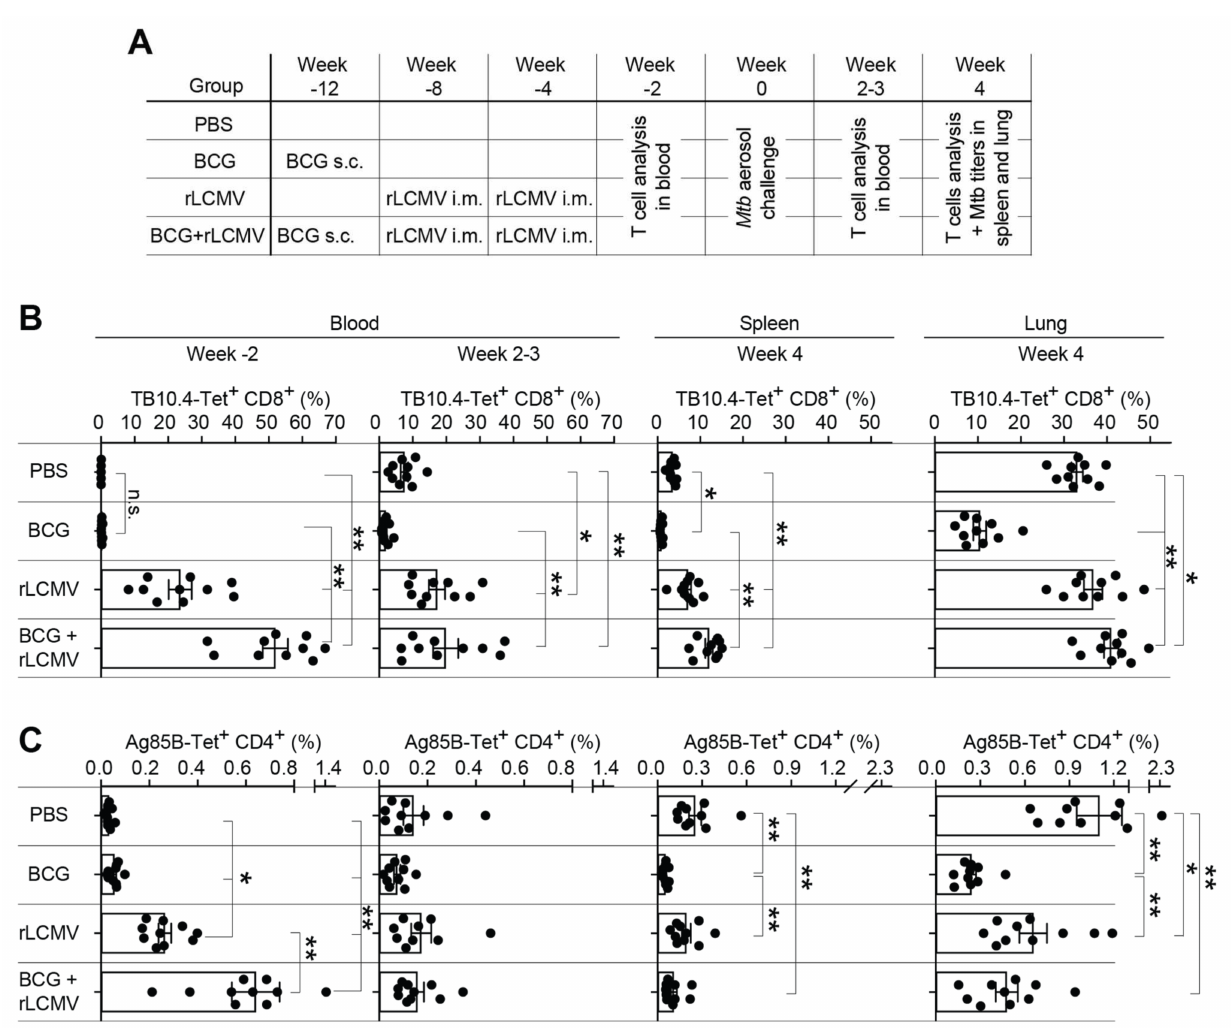
Figure 5. T cell responses upon rLCMV- and/or BCG immunization and subsequent Mtb aerosol challenge. ( A ): We immunized adult C57BL/6 mice with BCG s.c. and with rLCMV i.m. at the time points in the combinations indicated in the chart. rLCMV-induced TB10.4-specific CD8 T cells as well as Ag85B-specific CD4 T cells were determined in blood, spleen, and lung at the indicated time points prior to and after Mtb aerosol challenge. ( B ). We determined the frequencies of TB10.4 dextramer- binding CD8 T cells 2 weeks prior to and 2–3 weeks after Mtb challenge in blood and 4 weeks after Mtb challenge in spleen and lung. ( C ): We determined the frequencies of Ag85B tetramer-binding CD4 T cells 2 weeks prior to and 2–3 weeks after Mtb challenge in blood, and 4 weeks after Mtb challenge in spleen and lung. Symbols in ( B , C ) show individual animals from two groups of five mice each that were immunized and challenged independently. Bars show the mean+/- SEM. Data were analyzed by one-way ANOVA followed by Bonferroni’s post-test. * p < 0.05, ** p < 0.01; only statistically significant differences ( p > 0.05) are